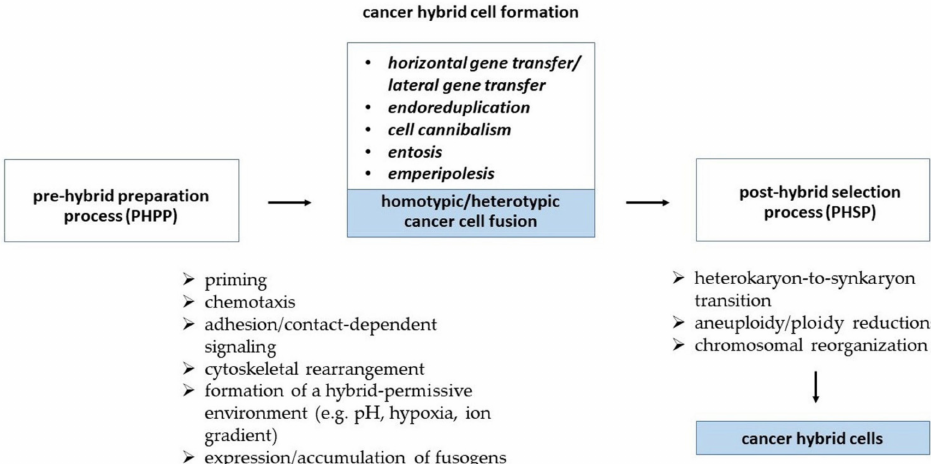
Figure 1. The formation of cancer hybrid cells is composed of an orchestrated sequence of distinct cellular programs which can be distinguished as (i) a pre-hybrid preparation process (PHPP), (ii) the cancer cell hybridization process, and (iii) a subsequent post-hybrid selection process (PHSP). Several events can lead to cancer cell hybridization including the fusion of cancer cells with neighboring cancer cells (homotypic fusion) or with other cell types (e.g., macrophages, cancer-associated fibroblasts (CAFs), MSC) within the tumor microenvironment (heterotypic